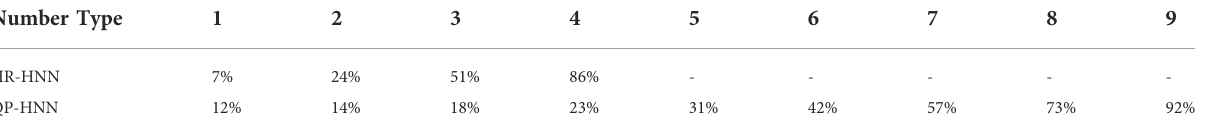
TABLE 1 Percentage of information required for